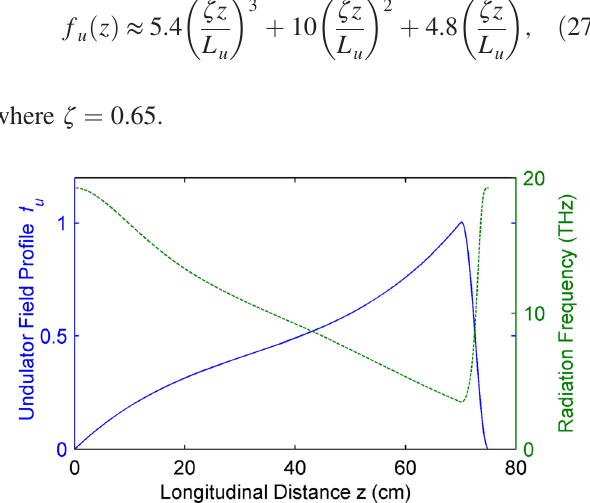
FIG. 6. Distances between the adjacent bunches and the resonant wavelength (17) along the undulator. The corresponding FIG. 5. Optimal undulator field envelope and radiation fre- ¼ 70 cm. temporal separation between the bunches is also quency vs distance in the undulator. L u